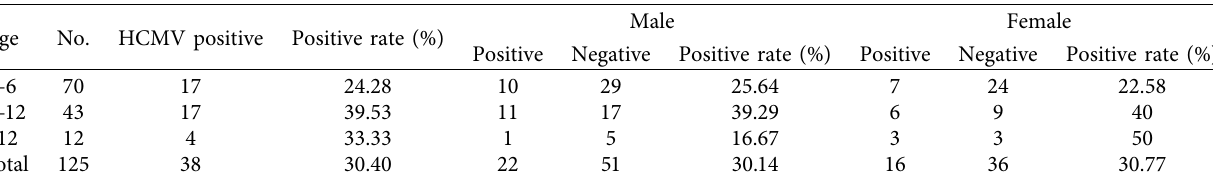
Table 3: HCMV infection rate by cdPCR in children following